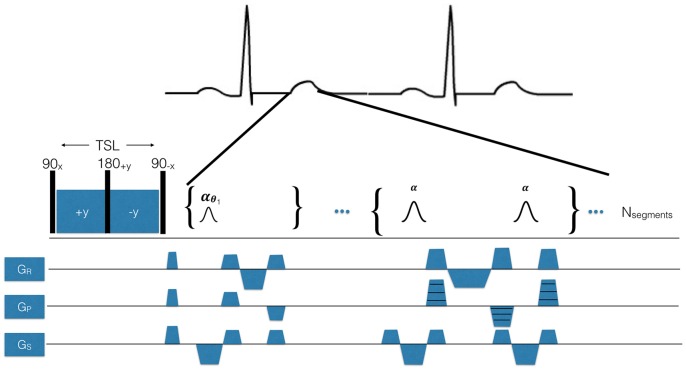
T1ρ pulse sequence designed for use in humans using breath-hold and electrocardiogram (ECG)-triggering.The pulse sequence is synchronized to the R-wave using a MRI- compatible vector ECG. The spin lock pulse cluster shown here is a spin lock, spin echo (90x-SLy-180+y-SL-y-90-x), consisting of a pair of continuous RF spin locking pulses with opposite phase ±y to refocus magnetization in a heterogeneous B1 magnetic field and a refocusing pulse to refocus B0. TSL is total spin lock time. After the T1ρ pulse cluster, a crusher gradient is delivered to eliminate remaining transverse signal and then a second magnetization preparation period employing a bSSFP flip angle ramp to stabilize the transverse magnetization prior to spatial encoding. The readout sequence employed is a single-shot bSSFP.